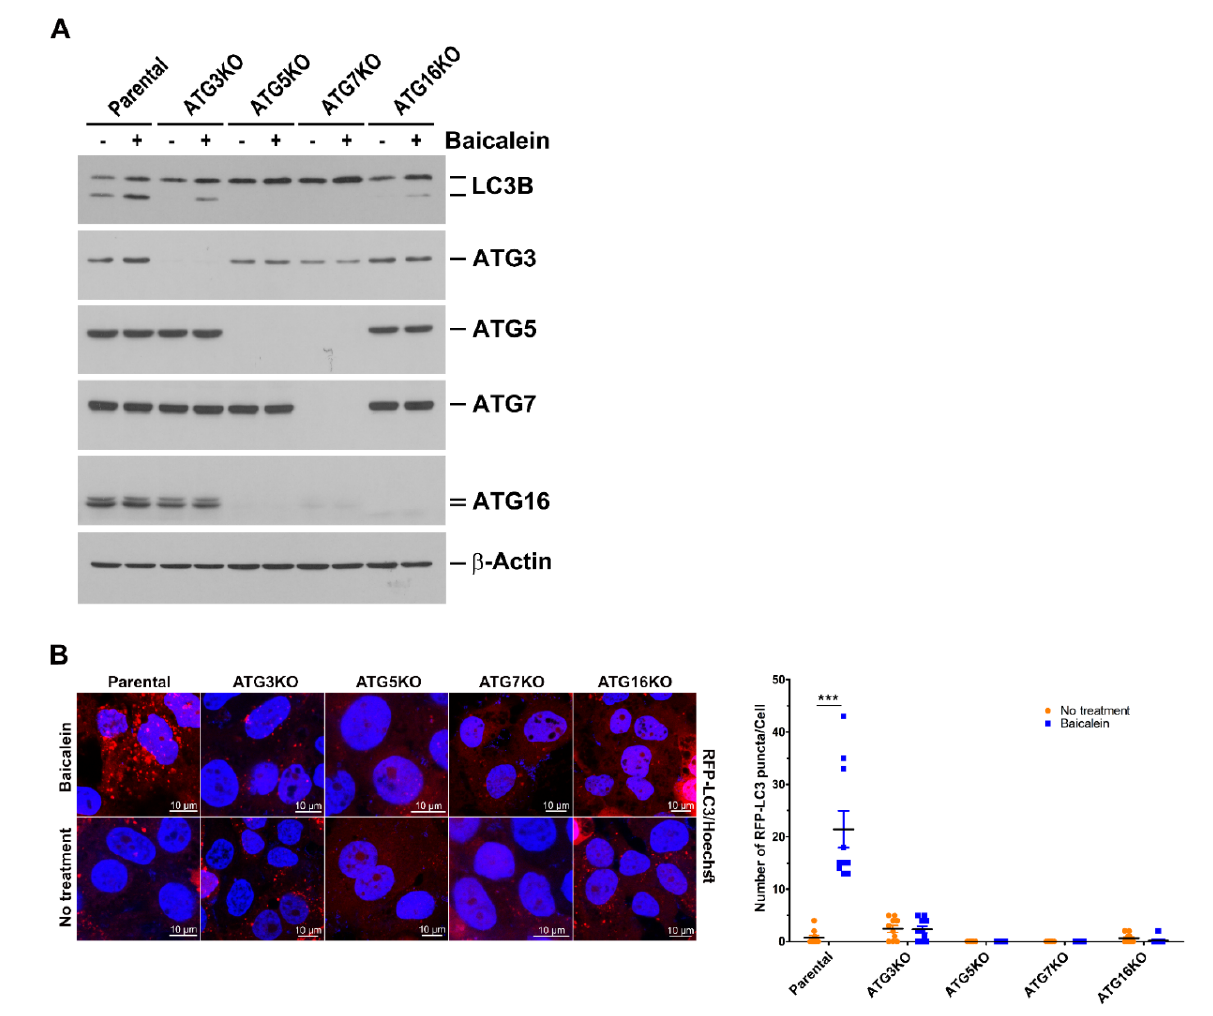
Figure 3. Dependence of the UBL conjugation system on baicalein-induced autophagy: ( A ) Individual ATG genes were knocked out in Huh7 cells by CRISPR/Cas9 gene editing as described in “Materials and Methods”. The parental and the individual ATG knockout (KO) cell lines were treated with or without 0.5 mM baicalein for six hours and harvested for analysis of protein expression by Western blotting. ( B ) Huh7 parental and individual ATG-KO cells stably expressing RFP-LC3 were established by lentiviral gene delivery and then treated with or without 0.5 mM baicalein. Four hours later, the cells were fixed, stained for nuclei with Hoechst 33342, and then analyzed by confocal microscopy. The number of RFP-LC3 puncta in parental and individual ATG-KO cell lines was quantified. The data represent the means ± SEM ( n = 10, *** p < 0.001).